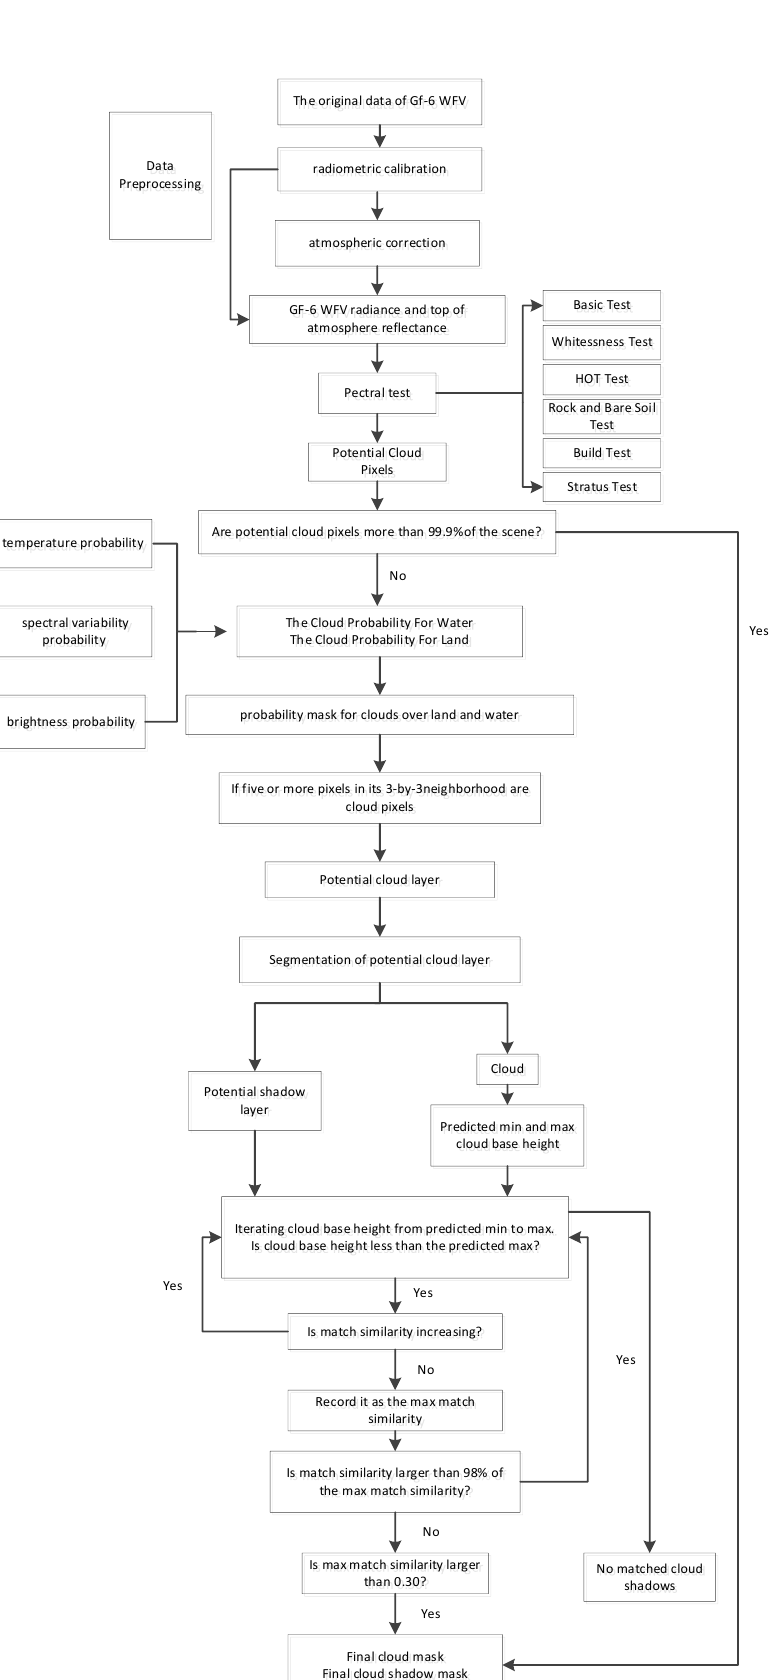
Figure 6. Flow chart of the improved Fmask algorithm for GF-6WFV data cloud detection.